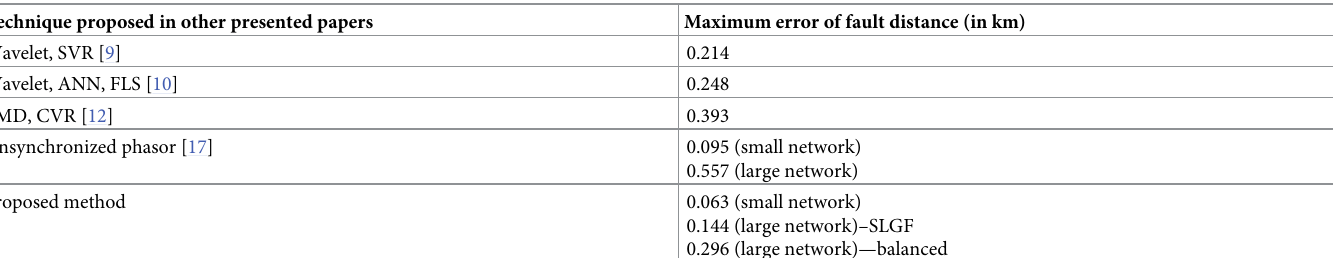
Table 16. Comparing the proposed method to existed